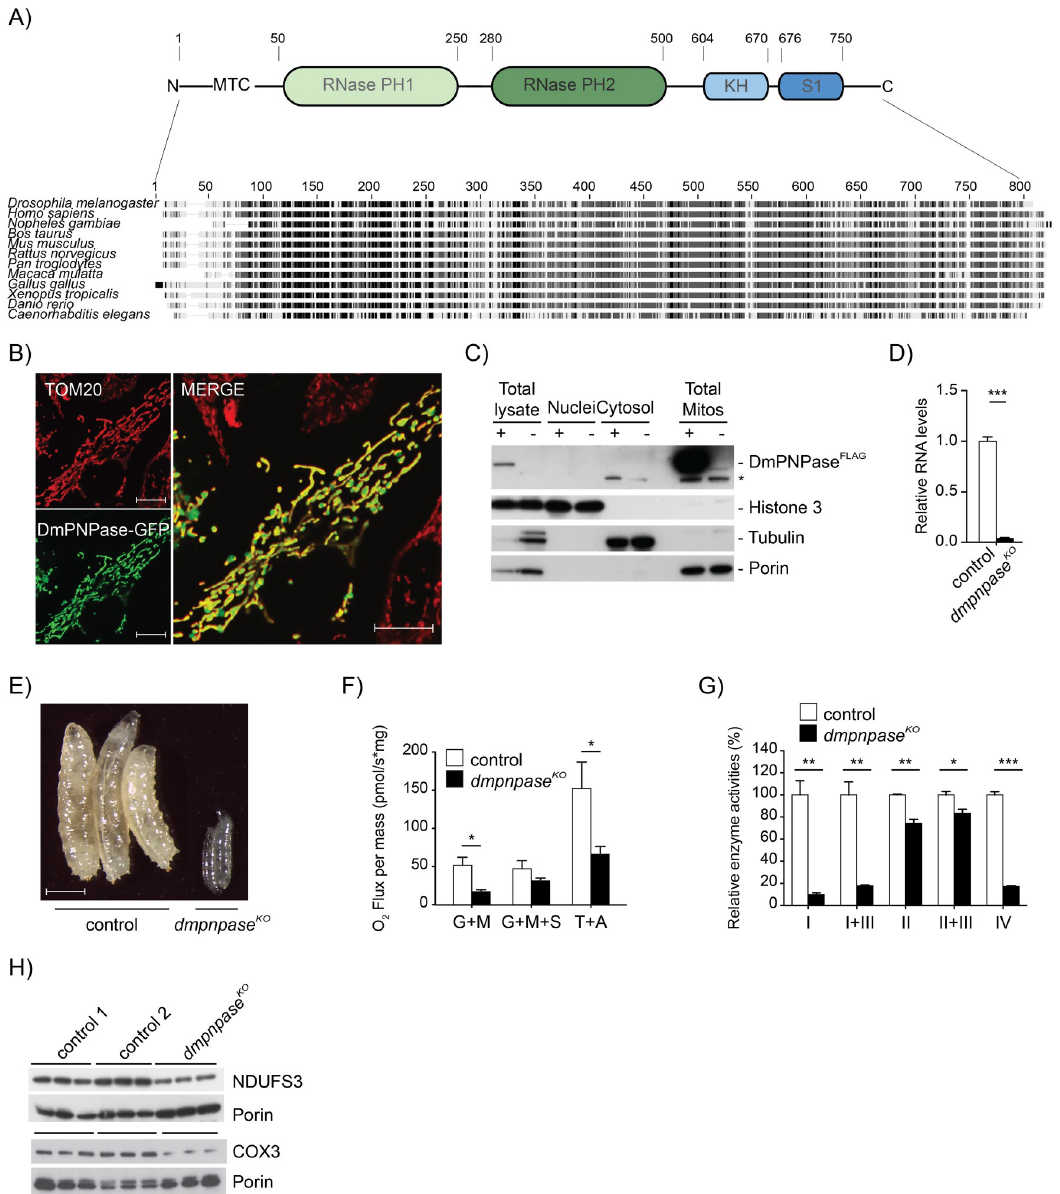
Fig 1. DmPNPase is a mitochondrial protein essential for development in Dm. ( A ) ClustalW alignment of several eukaryotic PNPase sequences, as well as a schematic representation of conserved domains in DmPNPase. ( B ) Confocal analysis of DmPNPase- GFP fusion protein localisation in HeLa cells decorated with TOM20 (red). Scale bars: 5 μ m ( C ) Western blot analysis of nuclear, cytoplasmic and mitochondrial fractions of DmPNPase-FLAG overexpressing larvae (w;;UAS- dmpnpase -flag/daGAL4). Antibodies against the FLAG peptide, tubulin, and histone H3 were used to assess the purity of the fractions; + indicates induced expression of the FLAG tag peptide. An unspecific band is indicated by an asterisk. ( D ) qRT-PCR of dmpnpase transcript levels in knockout (w;; dmpnpase KO / dmpnpase KO ) and controls (w;;) at 4 days after egg laying (AEL). Ribosomal Protein (RP) 49 transcript was used as an endogenous control. ( E ) Body size comparison in controls (w;;) and dmpnpase KO larvae at 4 days AEL, scale bar size 1mm. ( F ) Mitochondrial oxygen consumption in dmpnpase KO and wild type larvae ( w ;;). Measurements were performed on an Oroboros oxygraphy, using glutamate, malate and ADP (for complex I driven respiration), then succinate (for complex II driven respiration) and TMPD and ascorbate (for complex IV driven respiration). Error bars indicate the SEM of 9 independent experiments, each measurement was normalised to the protein content of each sample. ( G ) Isolated respiratory chain enzyme activities in dmpnpase KO and control. Mitochondrial protein extracts from larvae at 4 days AEL were assessed for complex I (NADH coenzyme Q reductase), complex I+III (NADH–cytochrome c reductase), complex II (NADH cytochrome c reductase), complex III (succinate dehydrogenase), complex II+III (succinate cytochrome c reductase) and complex IV (cytochorme c oxidase). ( H ) Western